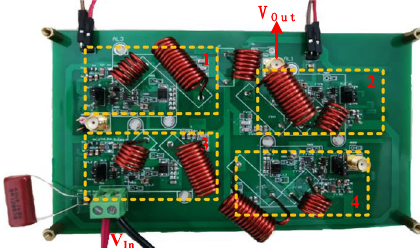
Fig. 10 High frequency multi-module inverter system prototype